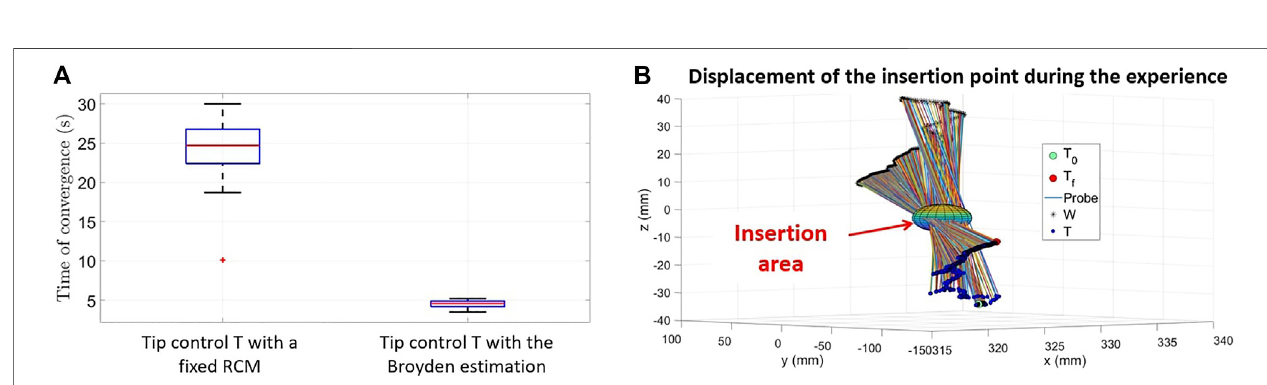
FIGURE 13 | (A) Convergence time for the 40 trials (Controller without adaptation vs Controller with adaptation) and (B) Highlighting of an “ insertion area ” in the developed experimental set-up.